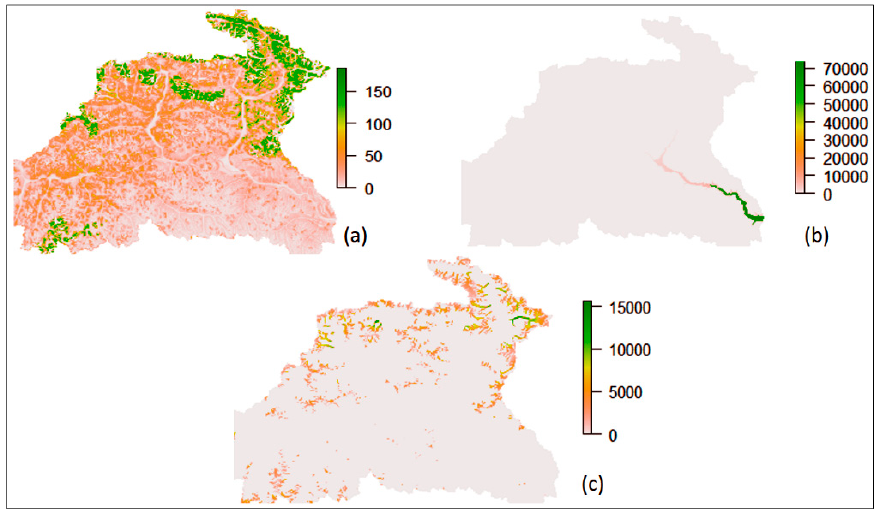
Figure 11. Routed runoff simulated by SPHY for 2010 at Gilgit River at Gilgit. ( a ) Rain runoff; ( b ) Snow runoff; ( c ) Glacier runoff (all units in cumecs (m 3 /sec)).